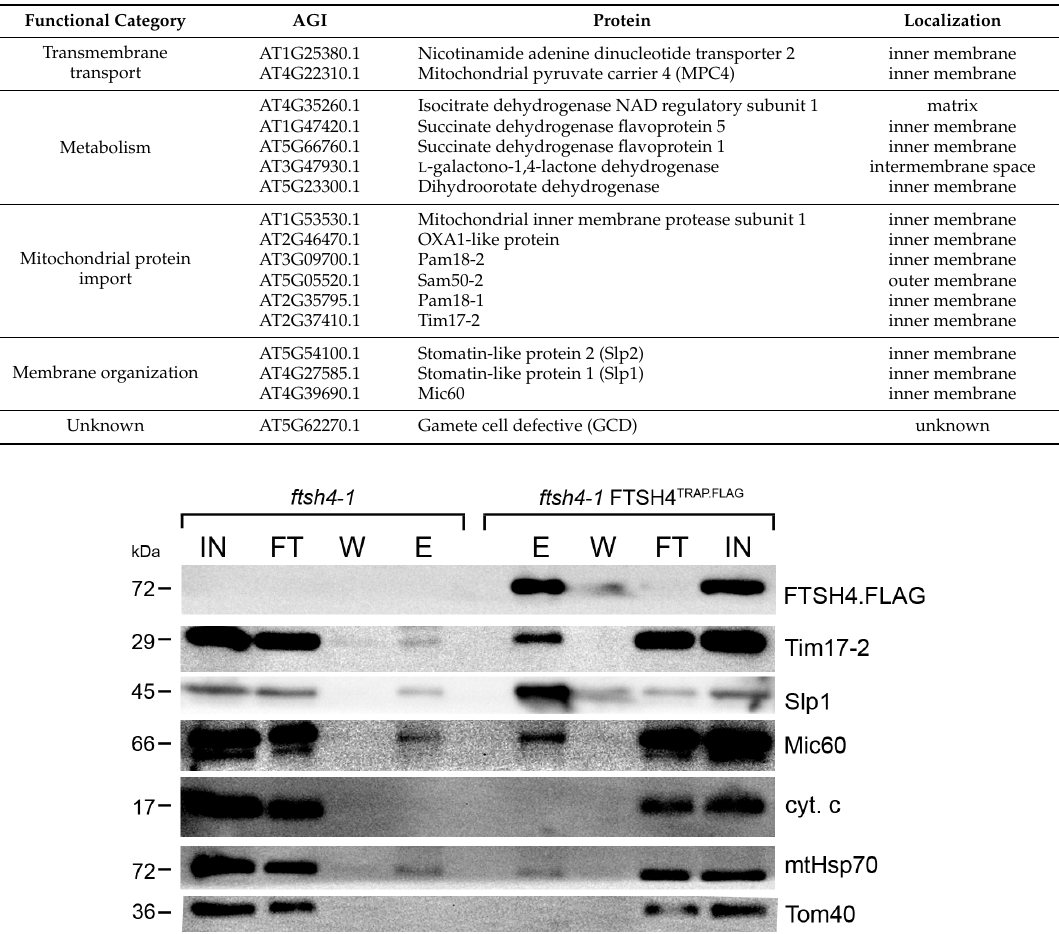
Figure 2. Immunoblot analysis of FTSH4 substrate trapping assay samples. Mitochondria from control ( ftsh4-1 ) and ftsh4-1 FTSH4 TRAP.FLAG were solubilized with digitonin and subjected to immunoprecipitation with anti-FLAG affinity matrix. The precipitated proteins were immunoblotted with antibodies against the indicated proteins. IN—input (5%), FT—flow-through (5%), W—Wash, E—eluate (50%).